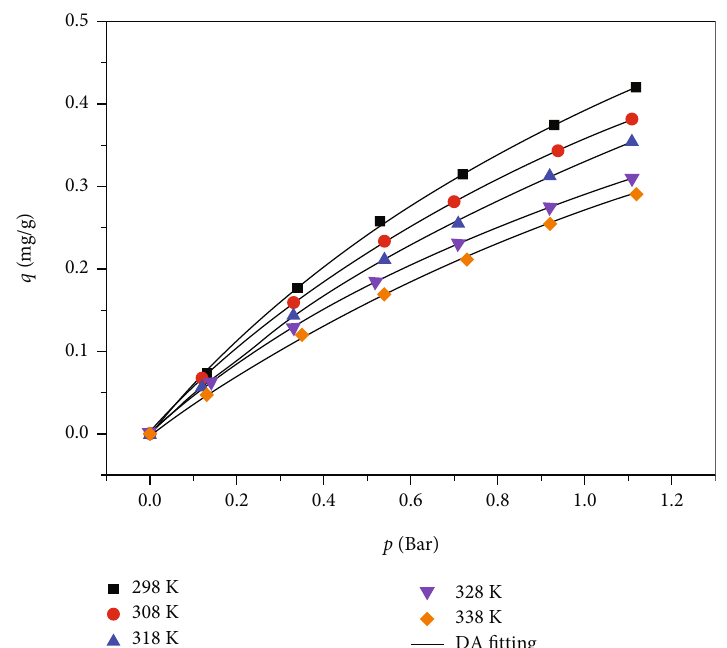
Figure 6: Adsorption isotherm and DA fi tting of HF on zeolite